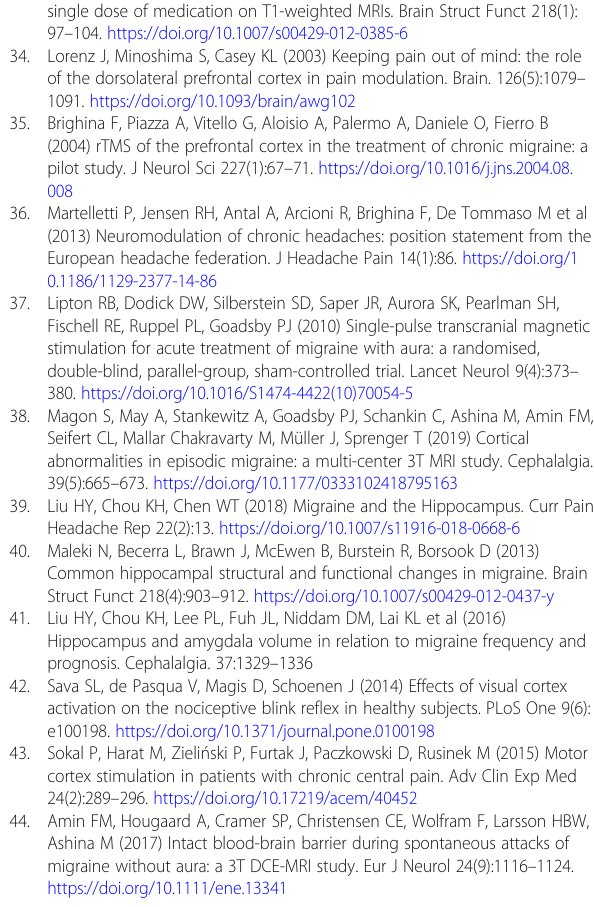
single dose of medication on T1-weighted MRIs. Brain Struct Funct 218(1): 97 – 104.